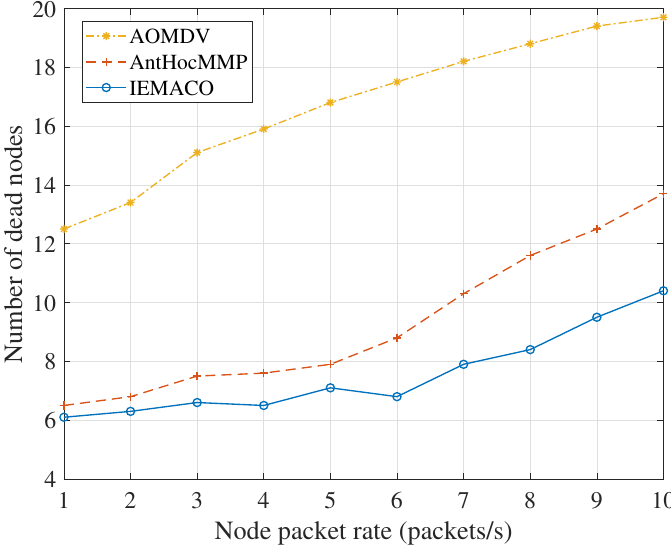
Figure 11. Number of dead nodes versus node packet